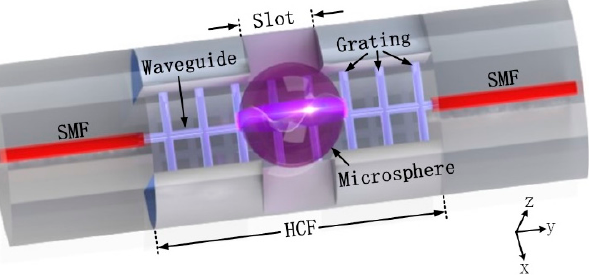
Figure 1. Schematic diagram of the polymer fiber-integrated whispering gallery mode (WGM)